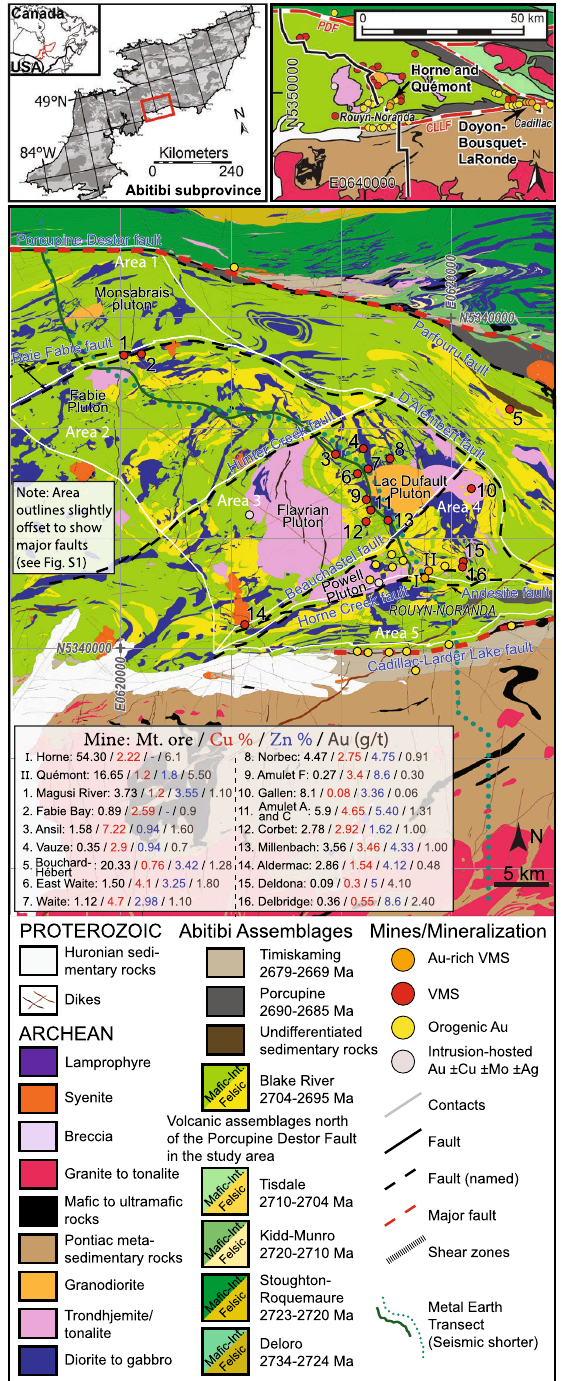
Figure 1. Geological map of the Noranda District with insets showing the study area (top left) and Doyon- Bousquet-LaRonde District (top right) locations. The maps in this Figure were generated in ArcGIS (≥ v. 10.5), Adobe Photoshop (≥ v. CC2019 20.0), and Adobe Illustrator (≥ v. CC2018 22.0.0) using open data downloaded from Système d’information géominière of Québec (SIGÉOM): https:// sigeom. mines. gouv. qc. ca/ signet/ class es/ I1102_ aLaCa rte?l=